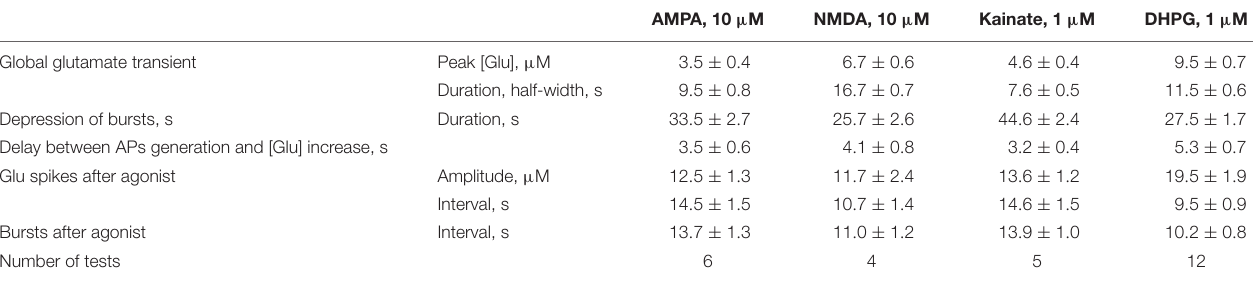
FIGURE 2 | Glutamate release in CA1 cells from the MeCP2-null animals (RTT) by GluR agonists and potentiation of repetitive activity after recovery. The protocols were the same as in the experiments presented in Figure 1 . Naive RTT slices demonstrated regular glutamate spikes. GluR agonists induced glutamate release (A) after increase in neuronal activity (B) . After brief augmentation of activity was depressed and restored after wash-out for several minutes. The glutamate spikes reappeared at significantly higher frequencies and amplitudes. The calibration bars apply for all traces and the scales are indicated only in the first panel. Table 2 gives the durations of global glutamate release and depression phases, and amplitude and frequency of glutamate spikes and bursts before and 10 min after the application of GluR agonists. TABLE 1 | Characteristics of responses elicited by glutamate agonists in CA1 neurons in slices prepared from wild-type (WT)